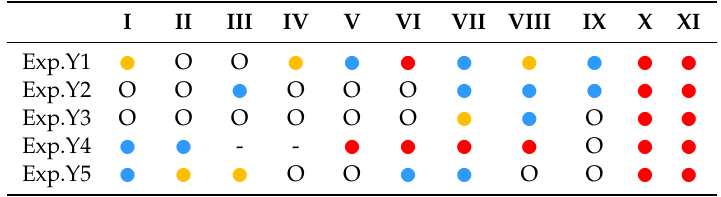
Table 6. MS intensity distribution of each stress stage. Note: “-” indicates inexistence of the